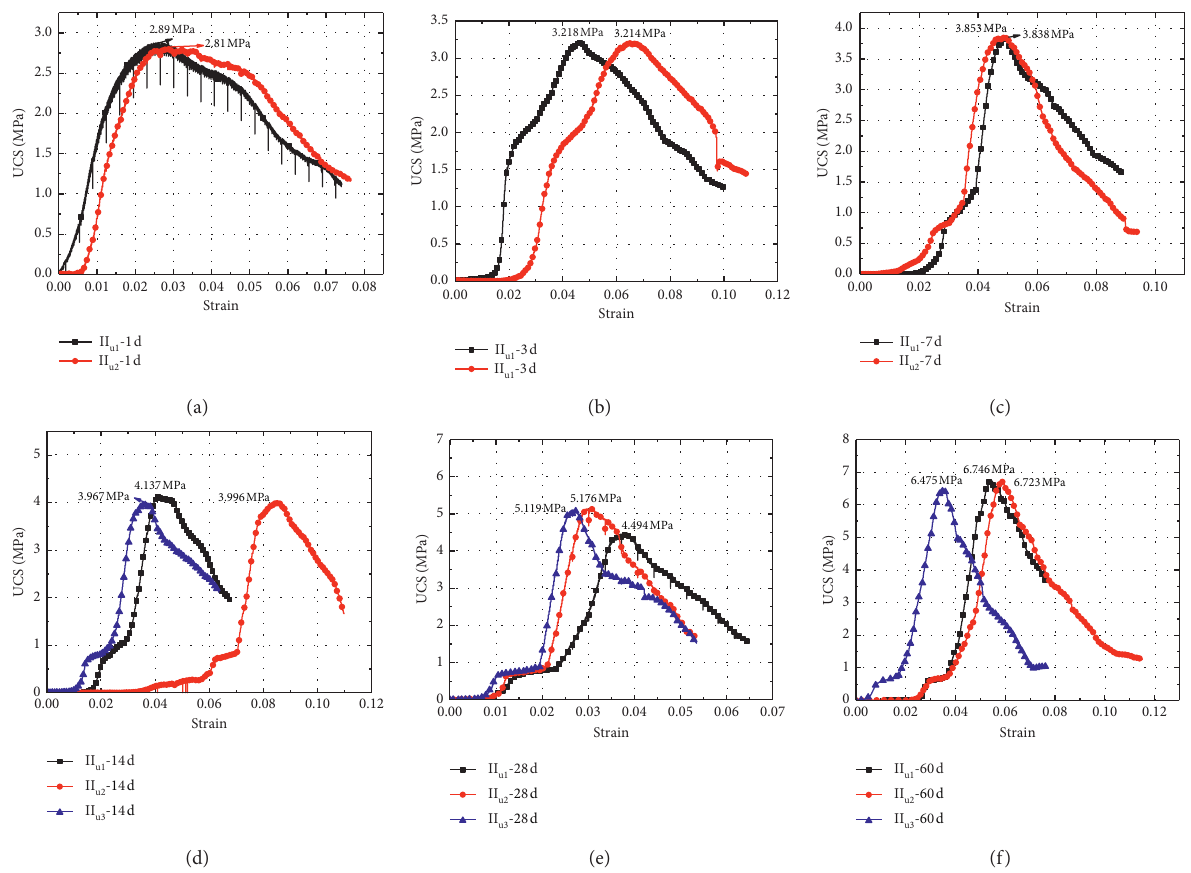
Figure 10: Mechanical strength of SCPB with different curing ages (glass fiber group II). (a) IIu-1 d. (b) IIu-3 d. (c) IIu-7 d. (d) IIu-14 d. (e) IIu-28d. (f)